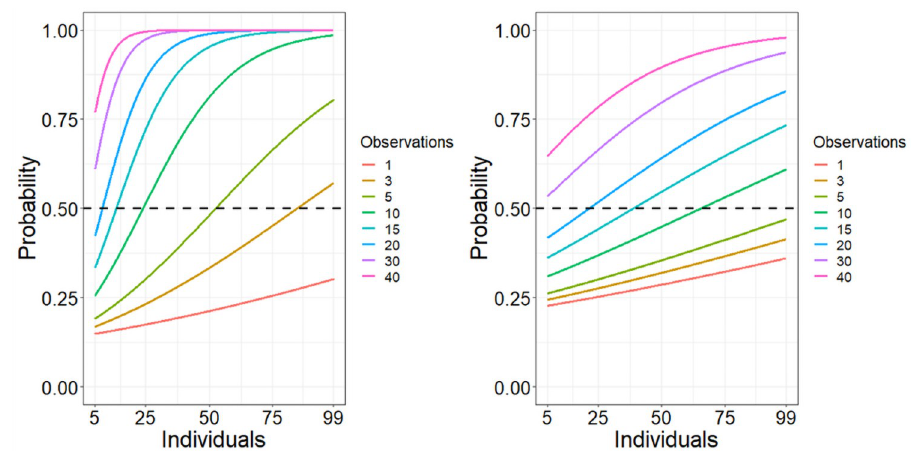
Fig 3. Probability of detecting community structure (A) and confident assortment of individuals (B). Detection of communities (A) is based on the p-value of modularity (Q; p < 0.05) and confident assortment of individuals (B) is based on obtaining a community assortativity coefficient (R com ) value that indicates a reasonable ability to assort individuals into communities ( � 0.5) without overestimating this ability based on the ‘observed’ network ( � 0.858).